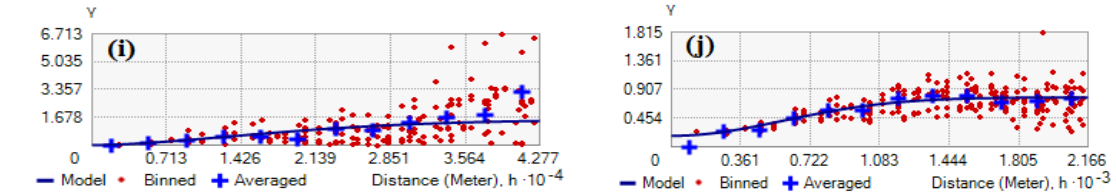
Figure 7. Spatial autocorrelation results by the related factors: ( a ) the altitude; ( b ) the slope angle; ( c ) the slope aspect; ( d ) the land use / cover; ( e ) the soil; ( f ) the distance to roads; ( g ) the distance to settlements; ( h ) the rainfall; ( i ) the temperature; and the ( j ) wind e ff ect. Table 2. Results of the semivariogram parameters by the related factors.